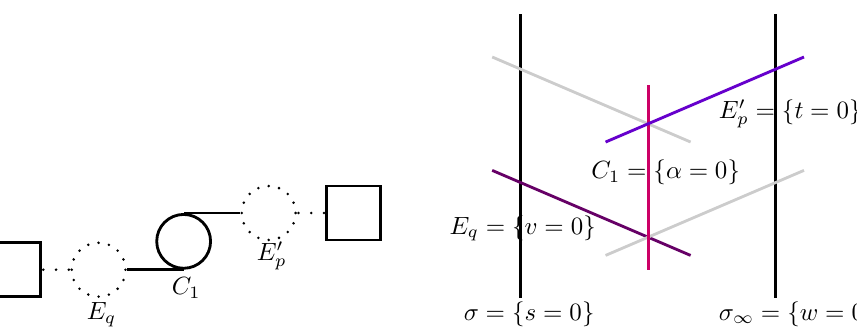
Figure 7. Solid (dotted) nodes denote the P 1 cycles yielding M-strings (E-strings). Solid (dotted) lines denote the 5-(7-)branes. Although this shows the connection structure among three P 1 ’s in the almost same way as (cid:12)gure 6, the cycle corresponding to C 1 is induced as the di(cid:11)erence between the other cycles, as in eq.